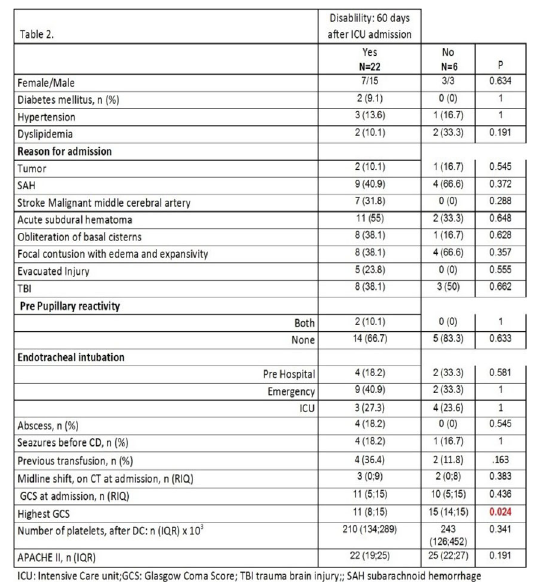
Table 2 (abstract 001016). See text for